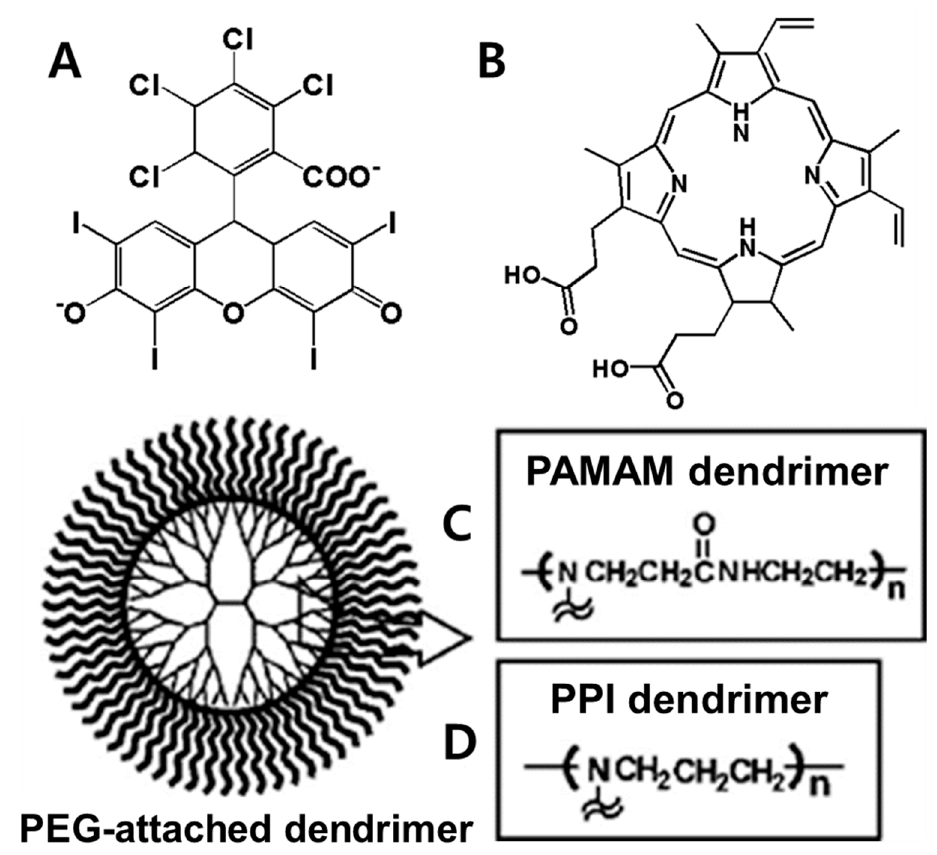
Figure 9. Structures of RB ( A ), PpIX ( B ), and PEG-attached PAMAM ( C ) and PPI ( D ) dendrimers. RB: rose bengal; PpIX: protoporphyrin IX; PEG: poly(ethylene glycol); PAMAM: poly(amido amine); PPI: poly(propylene imine). Reproduced with permission from Kojima, C.; Toi, Y.; Harada, A.; Kono, K. Preparation of poly (ethylene glycol)-attached dendrimers encapsulating photosensitizers for application to photodynamic therapy. Bioconjug. Chem. 2007 [169].